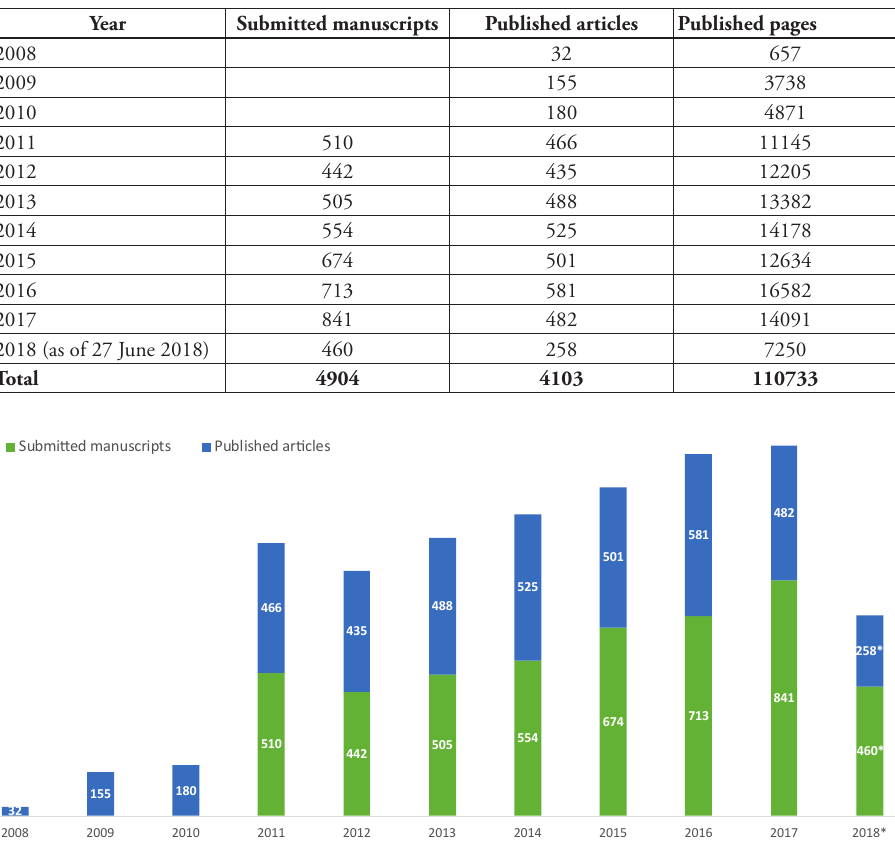
Figure 1. Growth of submitted manuscripts and published articles in ZooKeys from 2008 to 2018 (*until